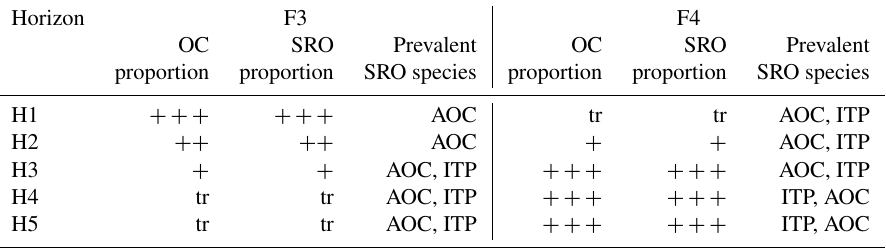
Table 4. Mass contribution of OC and short-range-ordered phases (SRO) to fractions three (F3) and four (F4). The grouping ranges from “ +++ ” (very abundant, >75wt%), “ ++ ” (abundant, 75–30wt%), “ + ” (low, 30–3wt%), to “tr” (traces, <3wt%). The prevalent short- range-ordered species are defined according to the molar proportion of imogolite-type phases on the short-range-ordered phases (ITP propor- tion of Table 3). For mean molar proportions of <33wt% Al–OM complexes (AOC) prevail. For molar proportions between 33and 67wt%, AOC and imogolite-type phases (ITP) are largely balanced, with the species listed first being slightly more abundant. For molar proportions >67wt% ITP